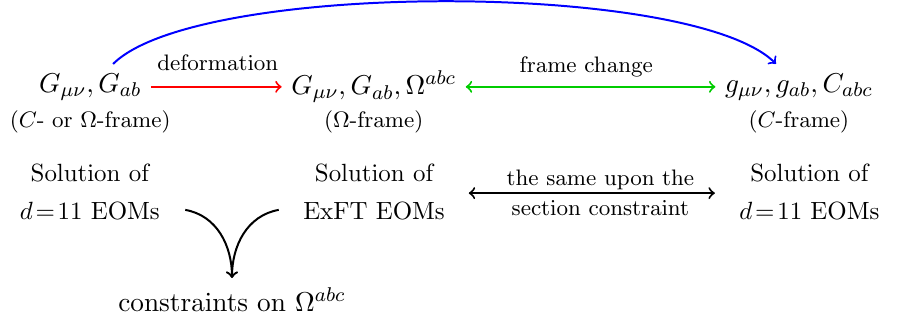
Figure 1 . The relationship between a background ( G (cid:22)(cid:23) ; G ab ) and its deformation ( g (cid:22)(cid:23) ; g ab ; C abc ). Starting with a background with C abc = 0 one switches to the (cid:10)-frame and simply turns on (cid:10) abc (red arrow). Switching to the C -frame one obtains a deformed background (green